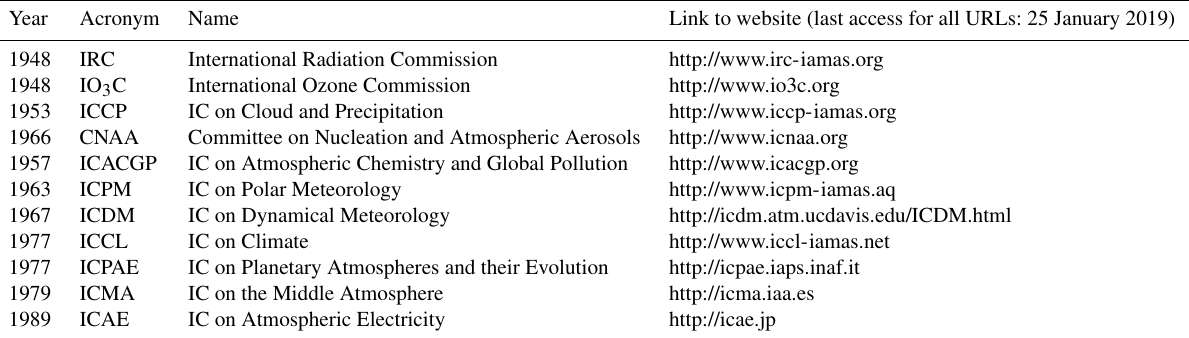
Table 5. International commissions (IC) within the International Association of Meteorology and Atmospheric Sciences, listed by year of formation.